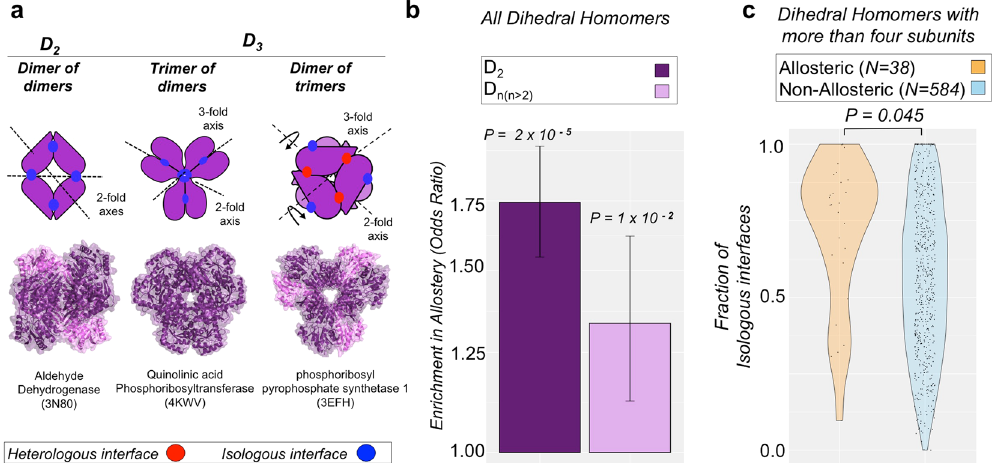
Figure 3. Allostery is associated with the present of isologous intersubunit interfaces. ( a ) Cartoon representation of the intersubunit interactions D 2 and D 3 complexes. D 2 complexes have two perpendicular twofold symmetry axes and therefore have only isologous interfaces, whereas D 3 complexes can have either all isologous interfaces or a mixture of isologous and heterologous interfaces. ( b ) Comparison of the enrichment in allostery between dihedral tetramers (D 2 ) vs. dihedral homomers with six or more subunits (D n(n > 2) ). P -values are calculated with Fisher’s exact test and error bars represent 68% melded binomial confidence intervals. ( c ) Density plot illustrating the distribution of isologous interfaces in the allosteric (orange) and non-allosteric (light blue) sets of dihedral complexes with more than four subunits. The P -value is from the two-sample Wilcoxon